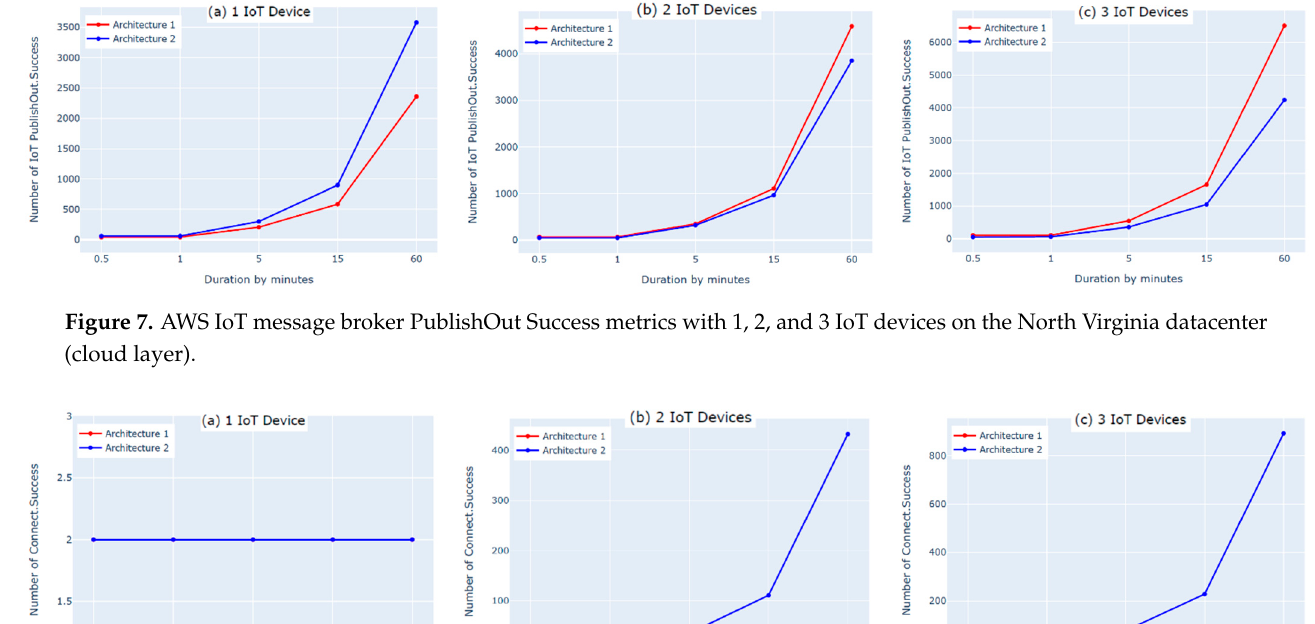
Figure 6. AWS IoT message broker PublishIn Success metrics with 1, 2, and 3 IoT devices on the North Virginia datacenter (cloud layer).